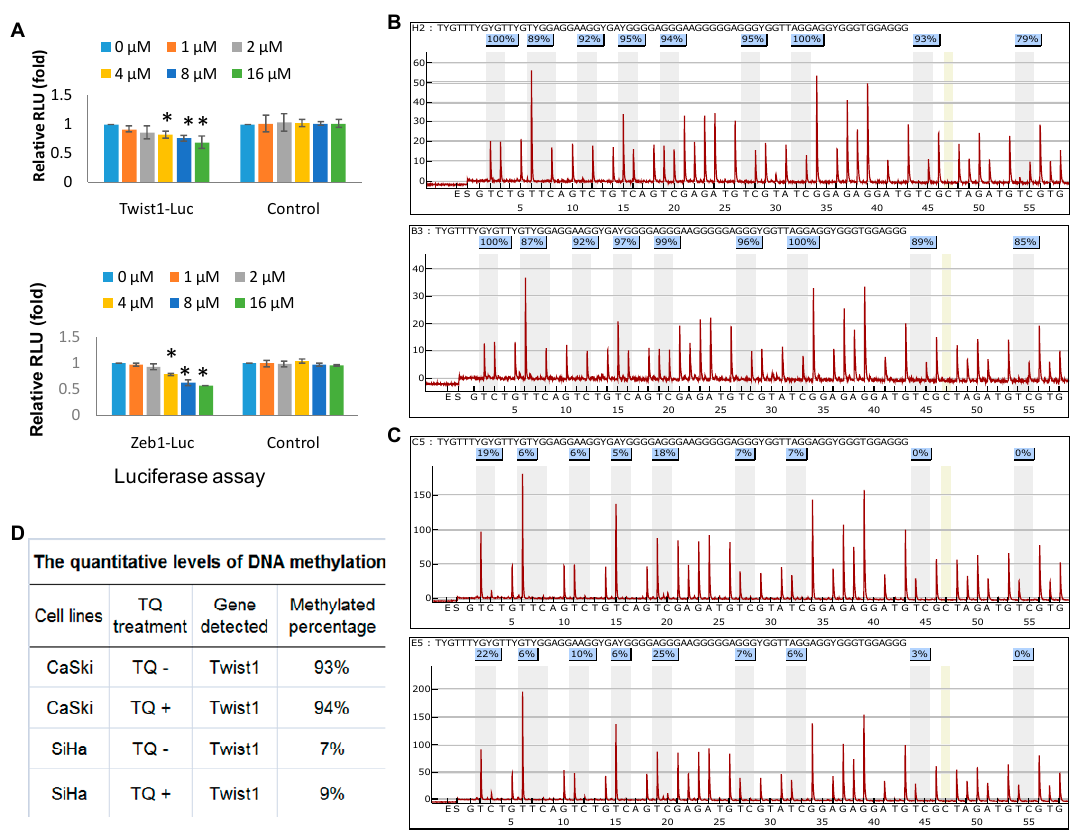
Figure 4. Effects of TQ on Twist1 and Zeb1 promoter activity. ( A ) Luciferase reporter assay shows that TQ decreased the Twist1 and Zeb1 reporter activity in SiHa cells, as the Relative Light Units (RLU) was decreased with the increase of TQ dosage. (* p < 0.05). The pyro-sequencing for the proximal promoter methylation of Twist1 gene without and with TQ treatment in cell lines CaSki ( B ) and SiHa ( C ) were performed, and quantitative changes indicate in ( D ).